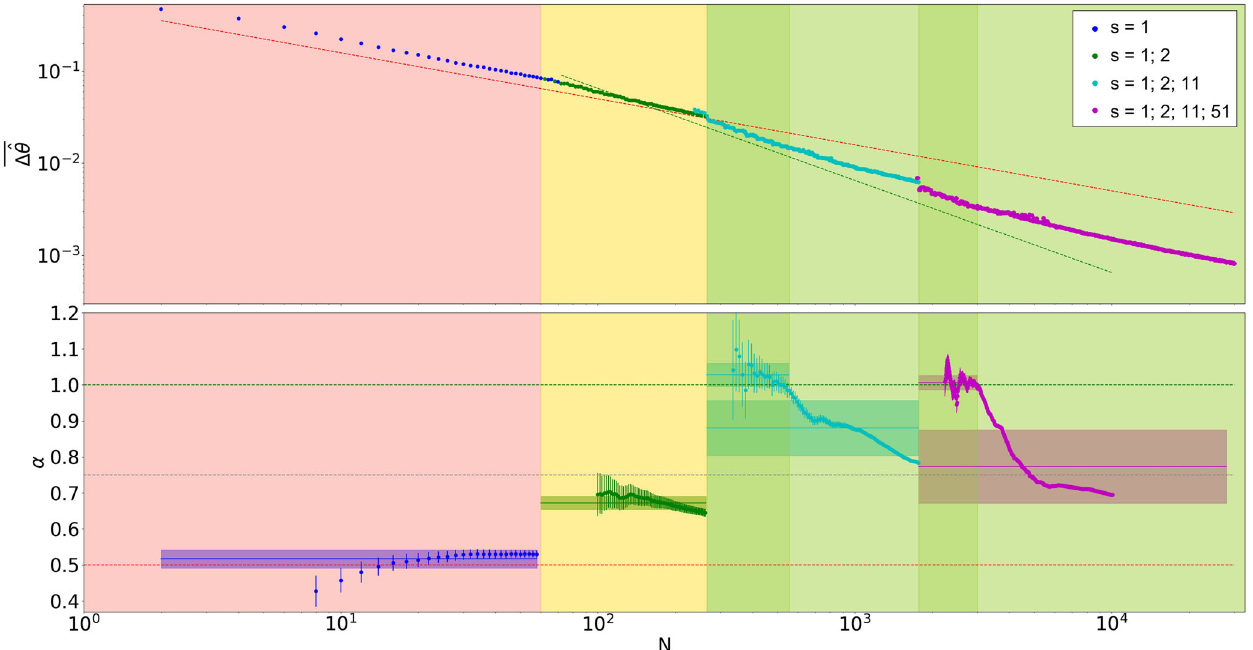
Fig. 4 Certi fi cation of the sensitivity scaling in the local scenario. Upper panel: measurement uncertainty averaged over 17 different angle values in the interval [0, π ) as a function of the number of resources N . We highlight the points with the color code associated with the maximum value of s exploited in each strategy. Blue points: strategies with s = 1. Green points: strategies relative to s = 1; 2. Cyan points: strategies relative to s = 1; 2; 11. Purple points: strategies for s = 1; 2; 11; 51. Error bars are smaller than the size of each point. Lower panel: the value of the coef fi cient α and the relative con fi dence interval for the four inspected regions. Such a con fi dence interval consists of a 3 σ region, obtained for the best fi t with function C / N α . The fi t is done on batches of data as described in the main text. The continuous lines show the average value of α in the respective region, while the shaded area is its standard deviation. The last reported point of α corresponds to the maximum batch of data which we can fi t all together with the function C / N α , without taking into account other sources of noise. In both the plots the salmon, yellow, and green colored areas represent, respectively, regions with SQL scaling ( α = 0.5), sub-SQL scaling (0.5 < α ≤ 0.75), and a scaling approaching the same power law of Heisenberg scaling (0.75 < α ≤ 1). The red dotted line represents the SQL ¼ 1 = ð 2 while the green one is the limit = C /(2 N ) (obtained fi xing α = 1 and C = 6 which has been arbitrarily chosen in order to have the Heisenberg scaling comparison close to the experimental data in the regions of interest). The gray dotted line is the threshold α =